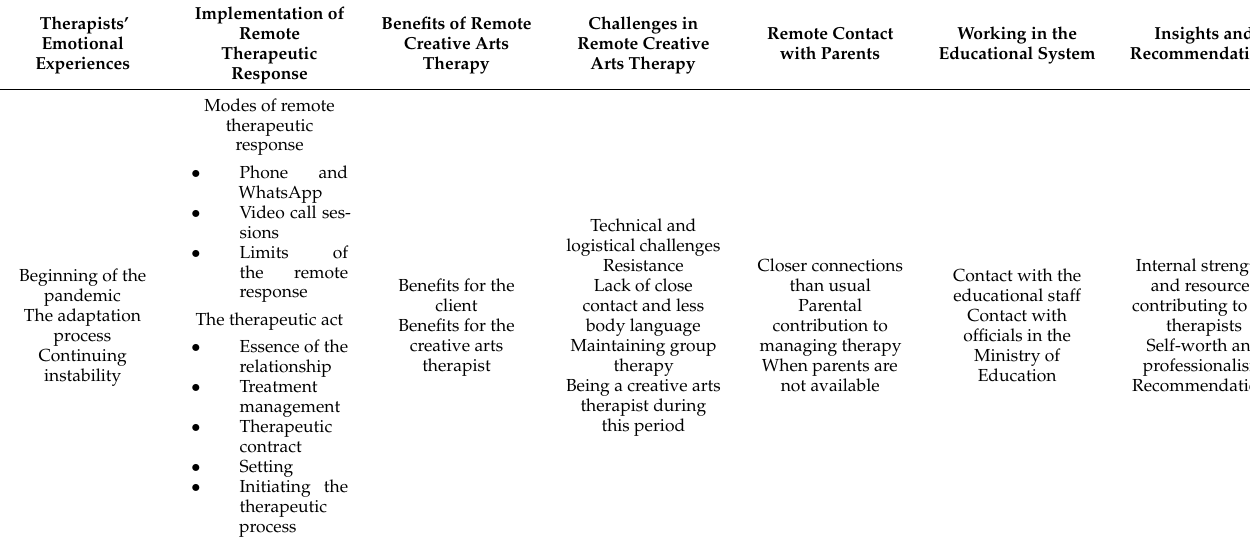
Table 1. Creative arts therapy in the “Remote Therapeutic Response” format as reported by partici- pants: Domains and core